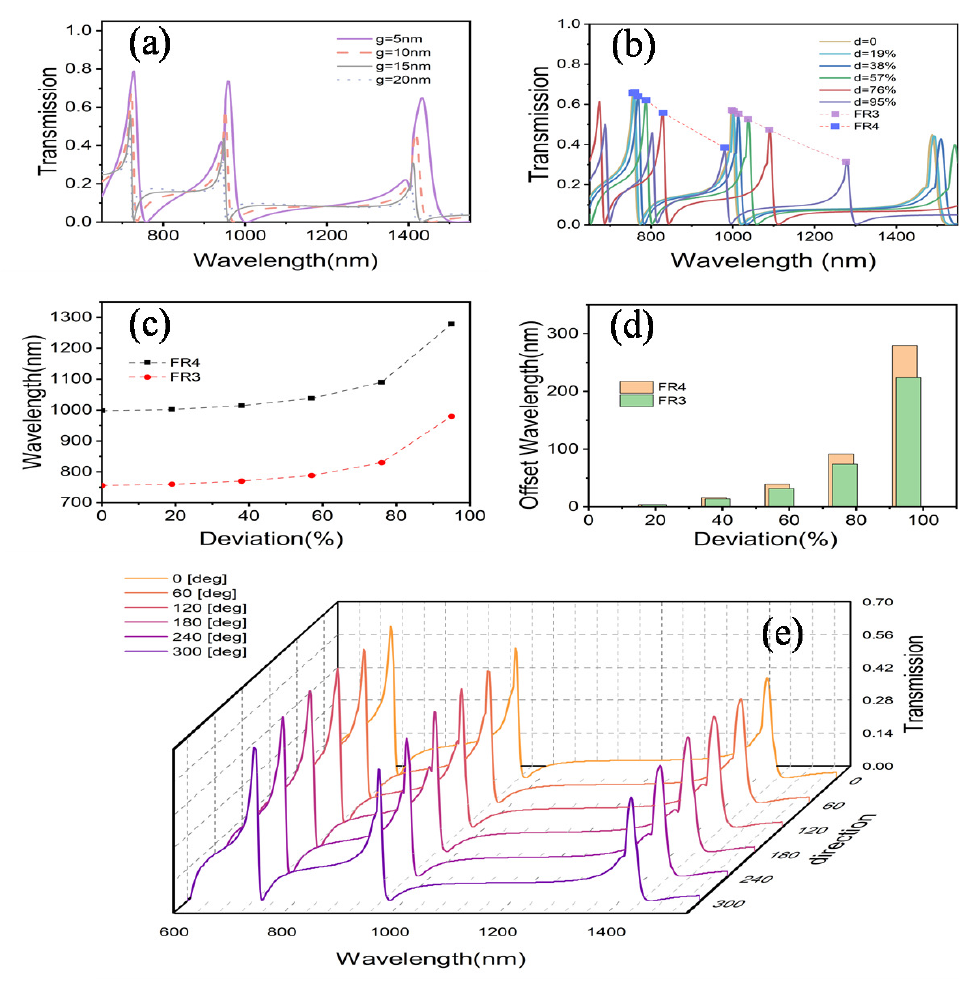
Figure 2. ( a ) Transmittance spectra for different coupling distances, g = 5 nm to g = 20 nm. ( b ) Transmittance spectra of the nanosensor with different eccentricity from 19–95%, where d = ( c ) The peak wavelength of FR3 and FR4 for different amplitude eccentric ring resonators in detail. ( d ) The offset in the peak wavelength of FR3 and FR4 in the annular cavity with different eccentricities. ( e ) Transmittance spectra of the nanosensor with different eccentric directions. When eccentricity amplitude is fixed, the direction does not change the transmission